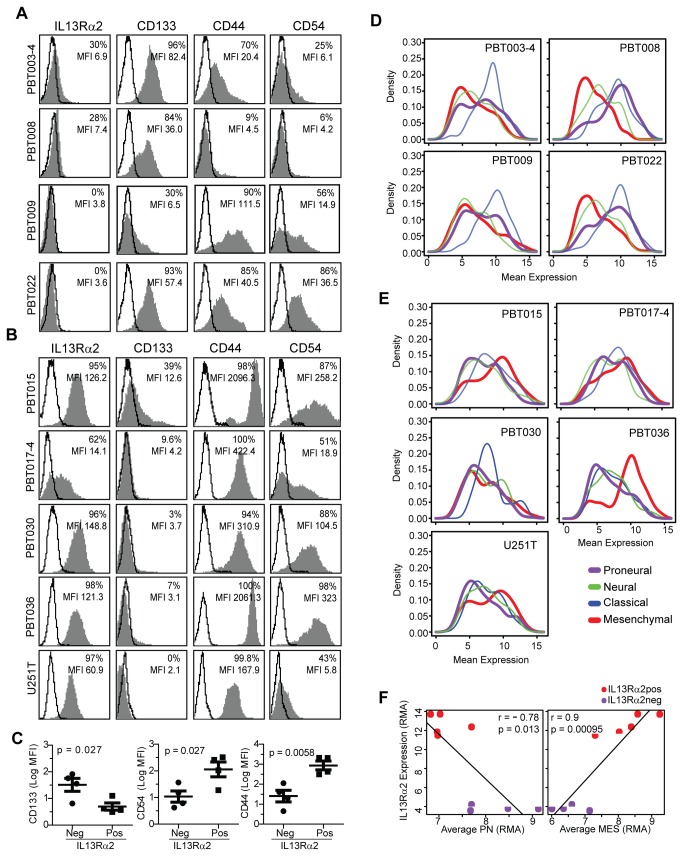
IL13Rα2 expression is associated with mesenchymal gene expression in low-passage primary glioma cell lines.Flow cytometry analyses of (A) IL13Rα2-negative glioma cell lines (PBT003-4, PBT008, PBT009, PBT022), and (B) IL13Rα2-positive glioma cell lines (PBT015, PBT017-4, PBT030, PBT036, and U251T) for expression of the proneural marker CD133 and mesenchymal markers CD44 and CD54/ICAM-1 (grey histograms). Solid lines show isotype and secondary control antibodies. (C) Comparison of mean fluorescence intensity (MFI) of IL13Rα2-negative and IL13Rα2-positive glioma cell lines shown in panels A and B. (D-E) Distribution plots of Affymetrix gene array expression analyses of (D) IL13Rα2-negative and (E) IL13Rα2-positive glioma cell lines for mesenchymal, classical, neural and proneural signature gene expression. (F) Correlation of mesenchymal (MES) versus proneural (PN) average gene expression with RMA normalized IL13Rα2 expression in glioma cell lines.